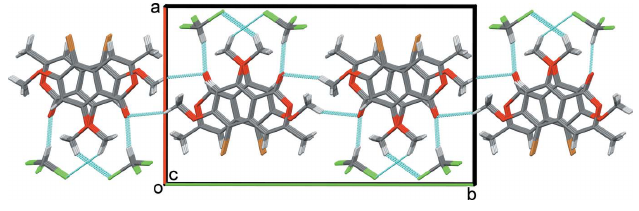
Figure 5 Aview along the c axis of the crystal packing of compound II (cid:2) CHCl 3 . The hydrogen bonds (Table 2) are shown as dashed lines.